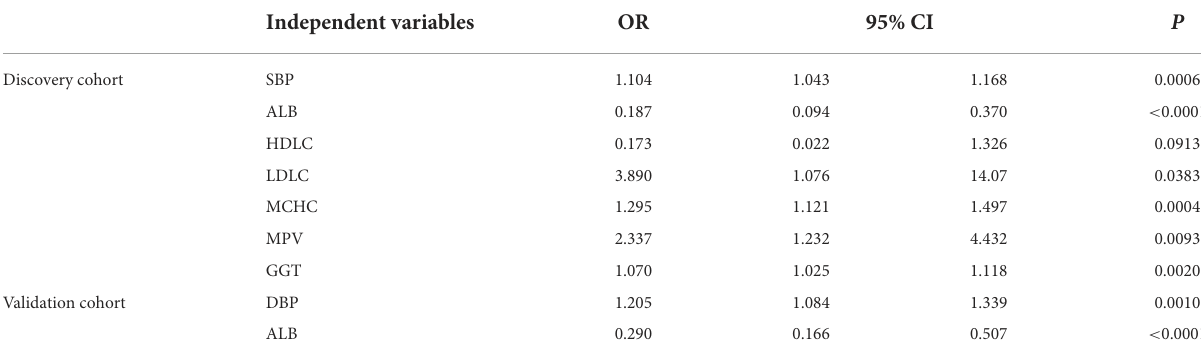
TABLE 3 Risk factor analysis of AF and Control in the discovery and validation cohort.